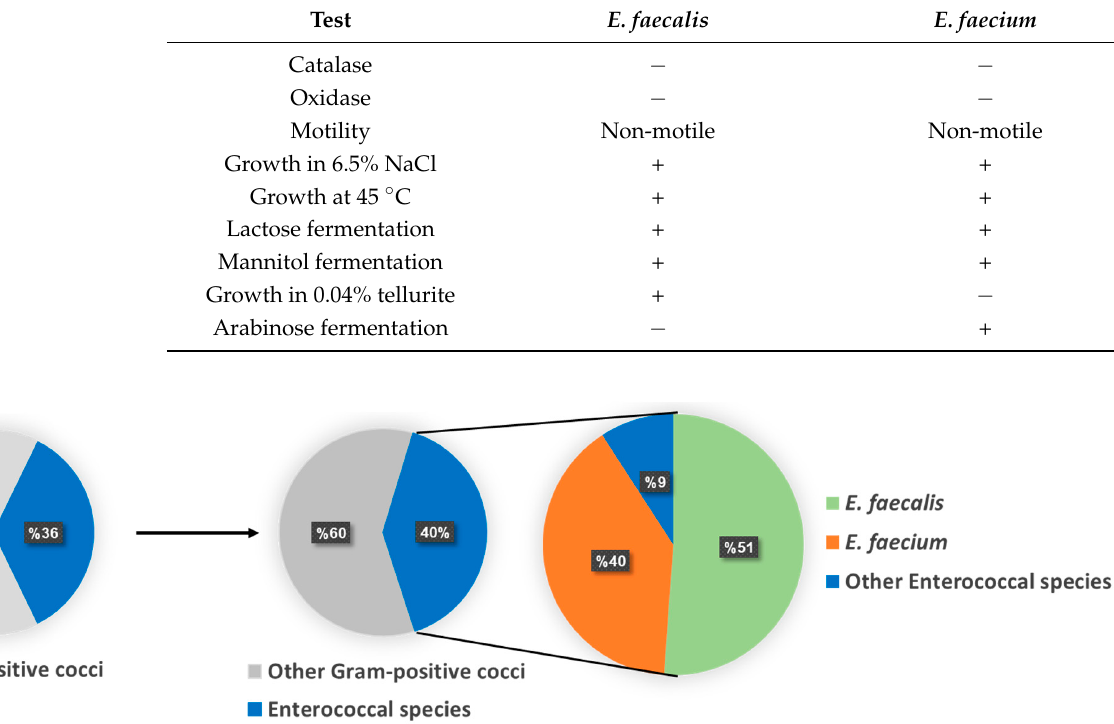
Figure 1. Incidence of Enterococcal spp. Among 913 clinical samples, 35.6% were Gram-positive cocci that contained about 40.3% Enterococci spp. Further, the Enterococcal spp. were presumptively distinguished into E. faecalis (51.1%), E. faecium (39.7%), or other Enterococci species (9.2%). Table 1. Biochemical characterization difference between E. faecalis and E. faecium.